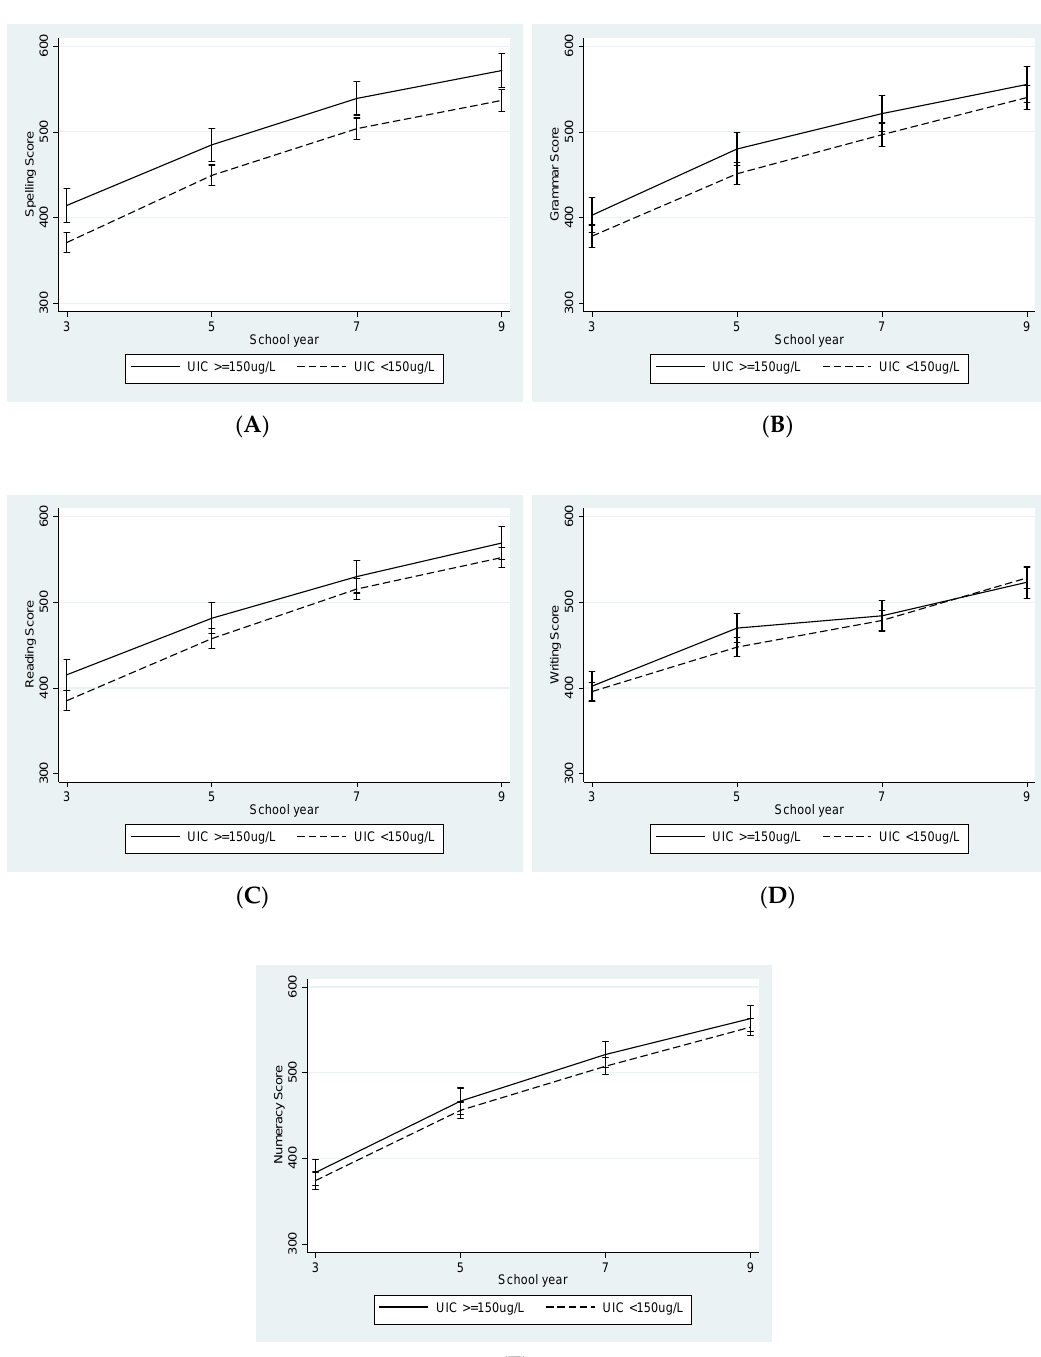
Figure 1. National Assessment Program–Literacy and Numeracy (NAPLAN) Scores for ( A ) Spelling, ( B ) Grammar, ( C ) Reading, ( D ) Writing, and ( E ) Numeracy from School Year 3 to Year 9 by maternal urinary iodine concentration (UIC), using data from the final mixed-effects multiple imputation using chained equations (MICE) models adjusted for biological factors, socio-economic status (SES), and adolescent UIC ( n = 266).